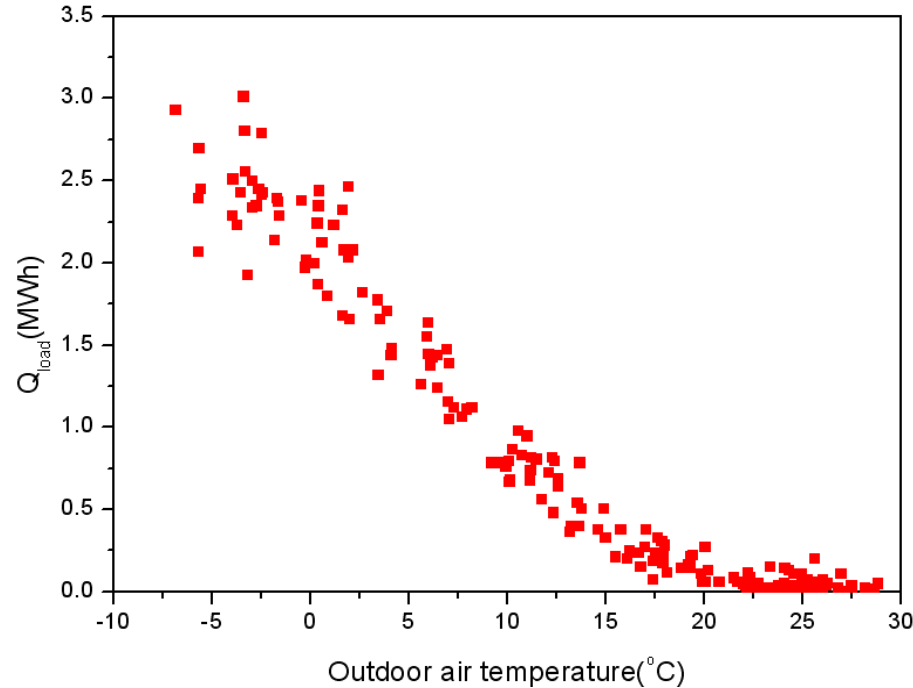
Figure 9. Variation of heating load of the model group energy apartment building according to outdoor air